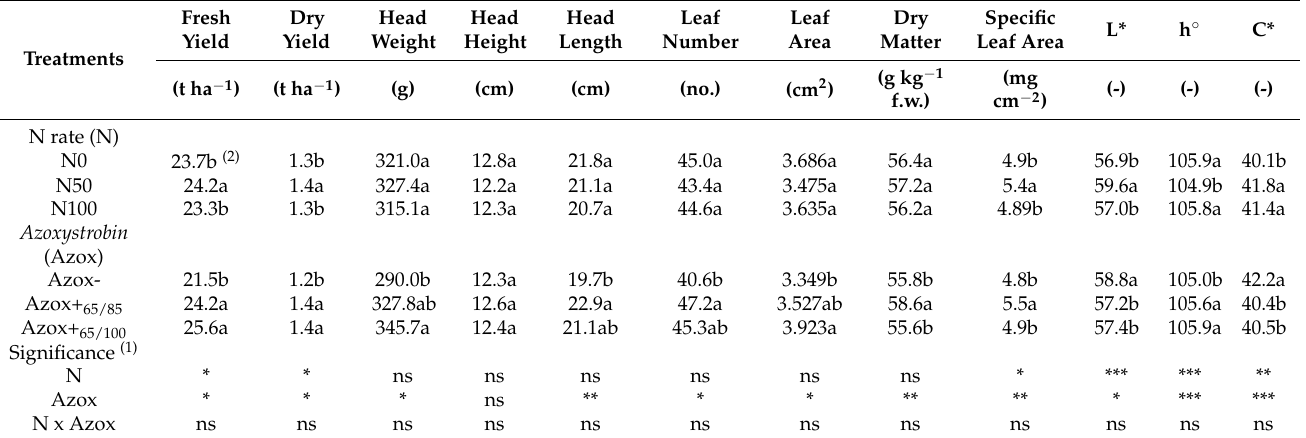
Table 1. Effect of N rate supply and azoxystrobin application on productive, morpho-biometric and visual quality traits of butterhead lettuce at harvest.